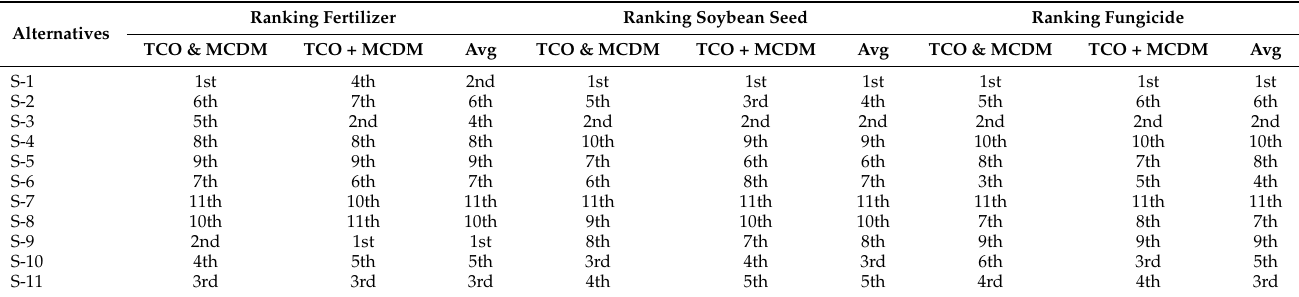
Table 12. Summary of Rankings (TCO & MCDM and TCO +